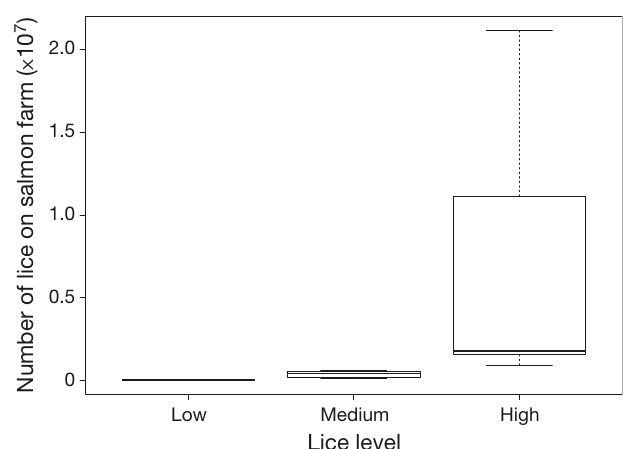
Fig. 2. Numbers of sea lice in each level of the categorical lice variable Lcat2 i . Summary statistics are the median of the data, the lower and upper quartiles (25% and 75%) and the minimum and maximum values. There are 8 data points (years) for the Low lice level, and 9 data points in each